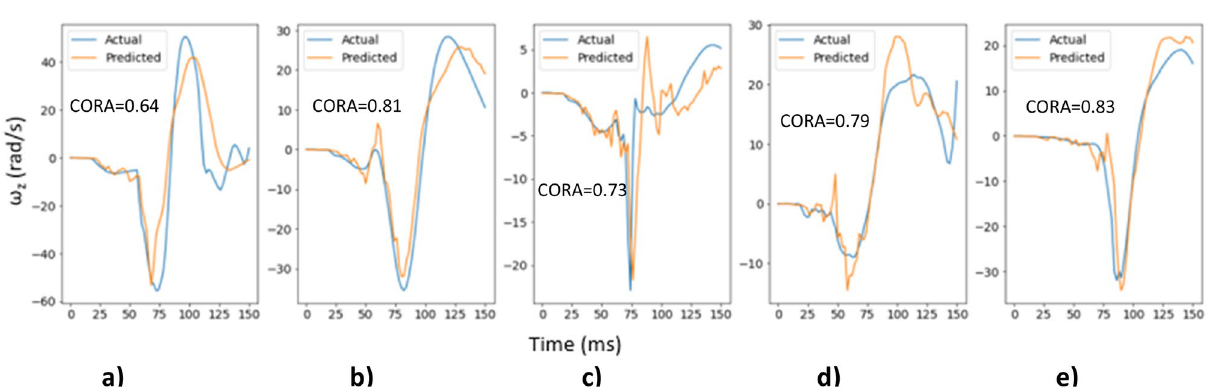
Figure 9. Actual and predicted time histories for ω y for 5 random cases from the test dataset.